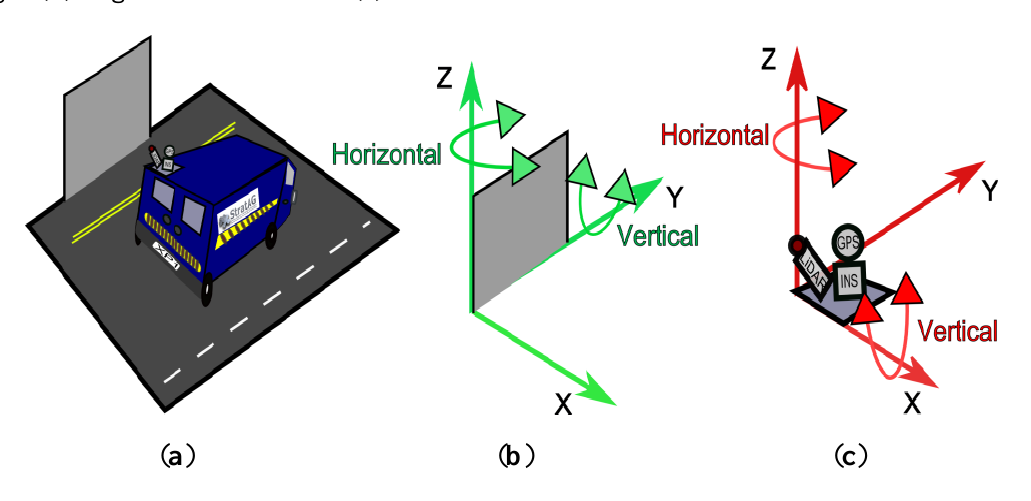
Figure 3. Horizontal and vertical axes of rotation for both target and scanner ( a ) MMS and target ( b ) target axes of rotation ( c ) scanner axes of